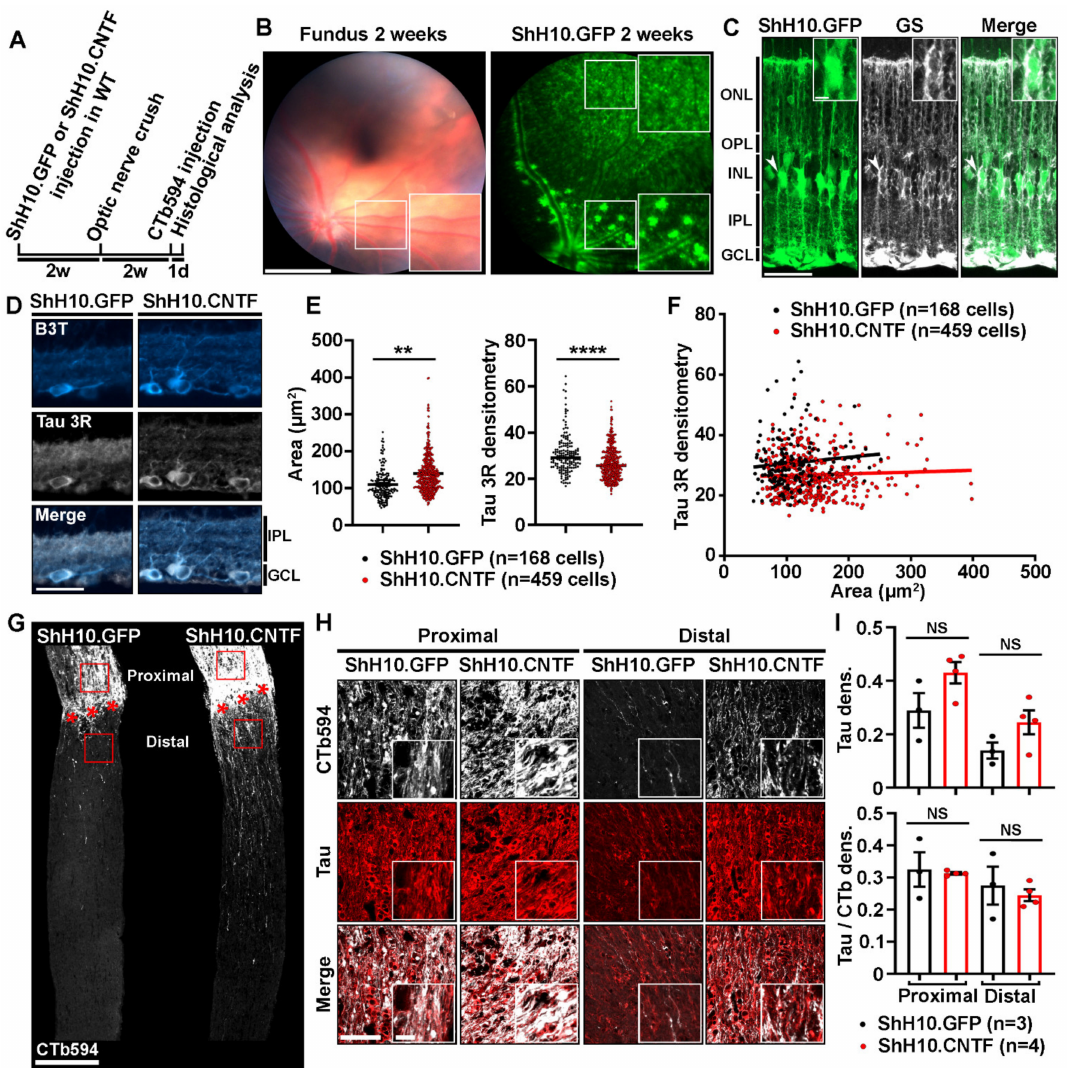
Figure 3. Tau expression is unchanged in the optic nerve axons of mice injected with ShH10.CNTF. ( A ). Experimental timeline. AAV2.ShH10.CNTF was used to activate injured retinal ganglion cell axon growth. AAV2.ShH10.GFP was used as control virus. Viruses were injected in the left eye of mice 2 weeks before optic nerve crush. At 2 weeks after injury, axons were traced with CTb594 the day preceding mouse sacrifice and retina and optic nerve processing. ( B ). In vivo observation of ShH10.GFP-mediated transgene expression. Retinal fundus examination with the Phoenix Micron IV microscope in anesthetized mice allowed to visualize GFP reporter expression 2 weeks after intravitreal delivery. Please note that Müller cell end feet were well visible from the periphery to the optic nerve head and all-around blood vessels. Scale bars: 500 µ m, close-up: 300 µ m. ( C ). Histological analysis of GFP transgene expression on retinal cryosections. Immunofluorescent staining revealed high virus-mediated expression of GFP protein in GS-expressing Müller glia at 4 weeks after ShH10 injection. Abbreviations: GS = Glutamine Synthase. GCL = Ganglion Cell Layer, IPL = Inner Plexiform Layer, INL = Inner Nuclear Layer, OPL = Outer Plexiform Layer, ONL = Outer Nuclear Layer. Scale bars: 50 µ m, close-up: 10 µ m. ( D ). Immunofluorescent staining of Tau 3R protein in retinal ganglion cells after infection with ShH10.GFP or ShH10.CNTF and optic nerve crush ( n = 4 mice per group). Retinal sections were collected at 4 weeks after ShH10 injection and at 2 weeks post-injury. Abbreviations: B3T = β 3-Tubulin, GCL = Ganglion Cell Layer, IPL = Inner Plexiform Layer. Scale bar: 50 µ m. ( E ). Tau 3R